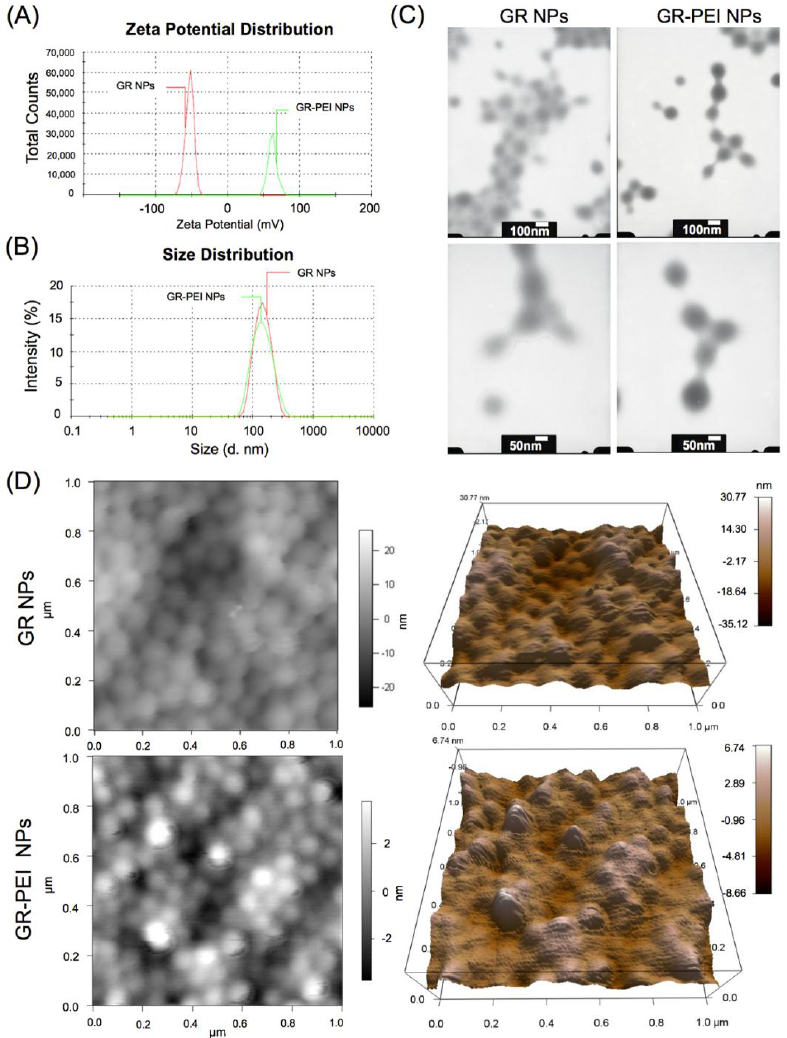
Figure 1. Physical characteristics of GR NPs and GR-PEI NPs. ( A , B ) The particle size of GR NPs and GR-PEI NPs showed the similar size distribution, but the zeta potential of GR NPs and GR-PEI NPs was different in neutral condition. ( C ) TEM images of GR NPs and GR-PEI NPs showed the spherical morphology by the preparation protocol in this study (upper panel: scale bar = 100 nm; lower panel: scale bar = 50 nm). ( D ) AFM images demonstrated the uniform and spherical morphology after surface modification.